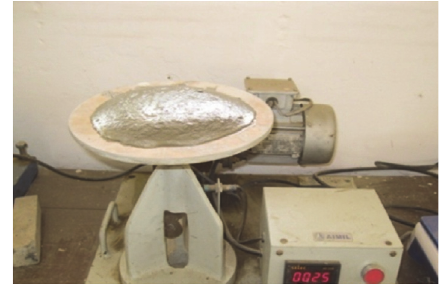
Figure 1: Flow test apparatus.